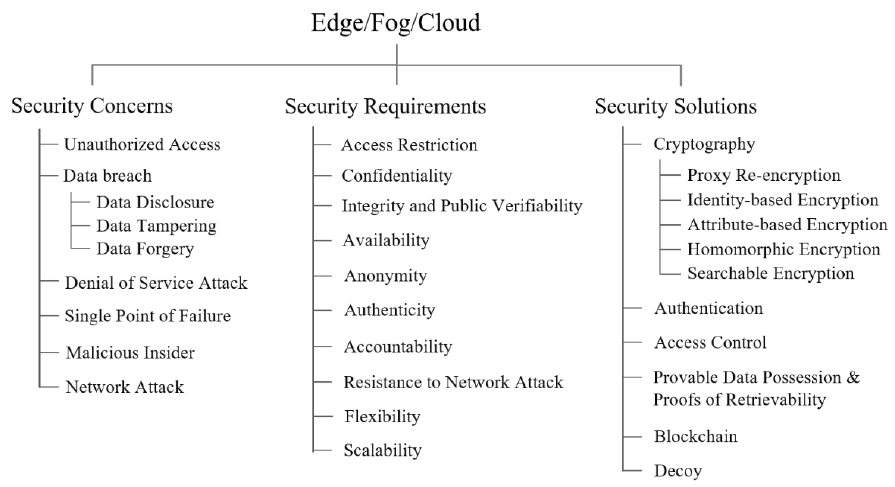
Figure 7. Taxonomy for security and privacy on edge, fog, cloud